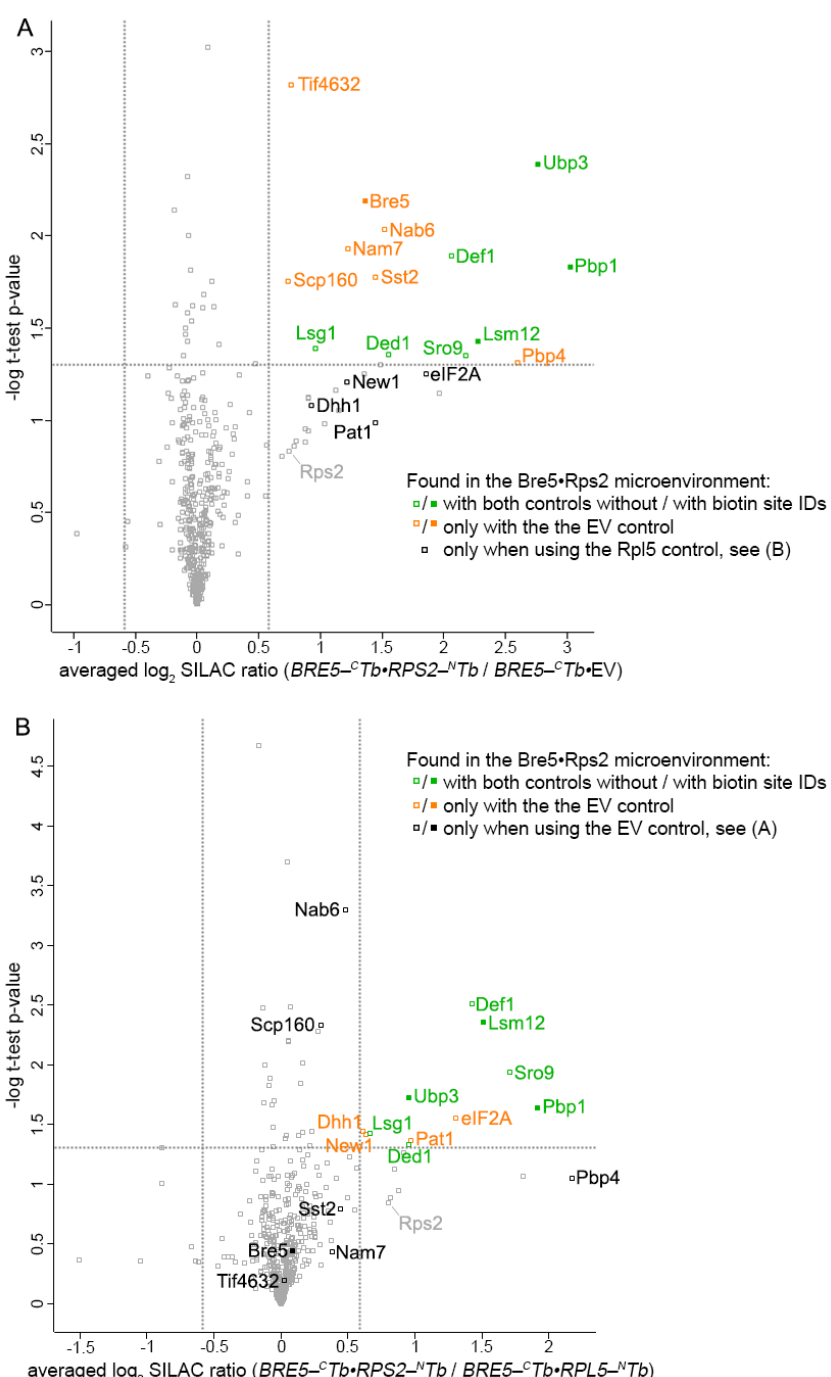
Figure 6. Proteins within a common microenvironment of Bre5 and Rps2. Volcano plots illustrate the averaged log 2 SILAC ratios for ( A ) BRE5- C Tb•RPS2- N Tb ( light SILAC) to BRE5- C Tb• EV ( medium SILAC) and ( B ) BRE5- C Tb•RPS2- N Tb ( light SILAC) to BRE5- C Tb•RPL5- N Tb ( heavy SILAC) on the x- axes and the -log 10 ( p -value) of the t-test on the y-axes. A p -value of 0.05 (horizontal) and a log 2 SILAC ratio of 0.585 or −0.585 (vertical) are indicated with gray dotted threshold lines. Proteins found as significantly enriched from the Bre5-Rps2 microenvironment with both controls are highlighted in green. Proteins in orange passed these thresholds for only one of the comparisons. For all labeled proteins, eluate ratios were corrected on total proteome ratios (input normalization). Gray squares represent proteins not passing the set criteria for proximity. For details see Tables S12–S15.